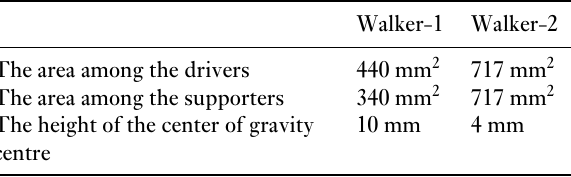
Table 2 The parameters for stability